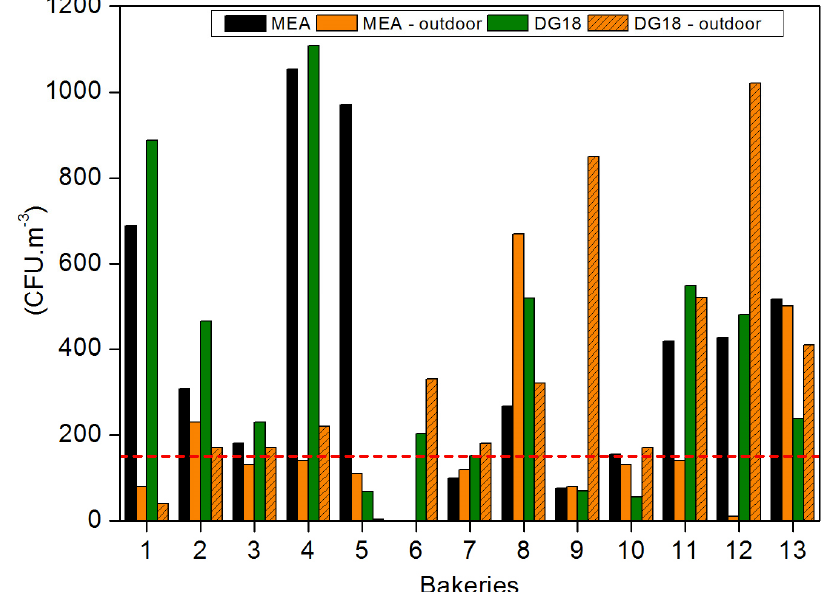
Figure 1. Air fungal load distribution in the 13 assessed bakeries. The dashed line represents the reference limits suggested by the World Health Organization (WHO).